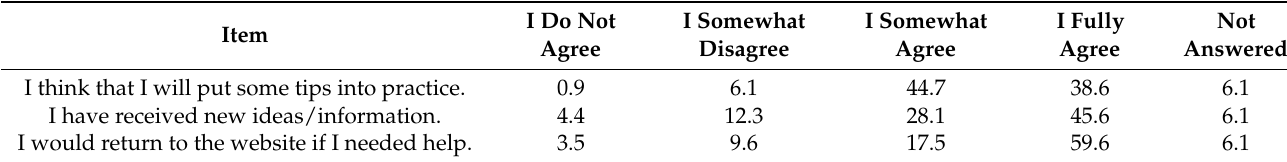
Table 4. Response rates to the statements concerning impulses for action (in percent, N = 114).